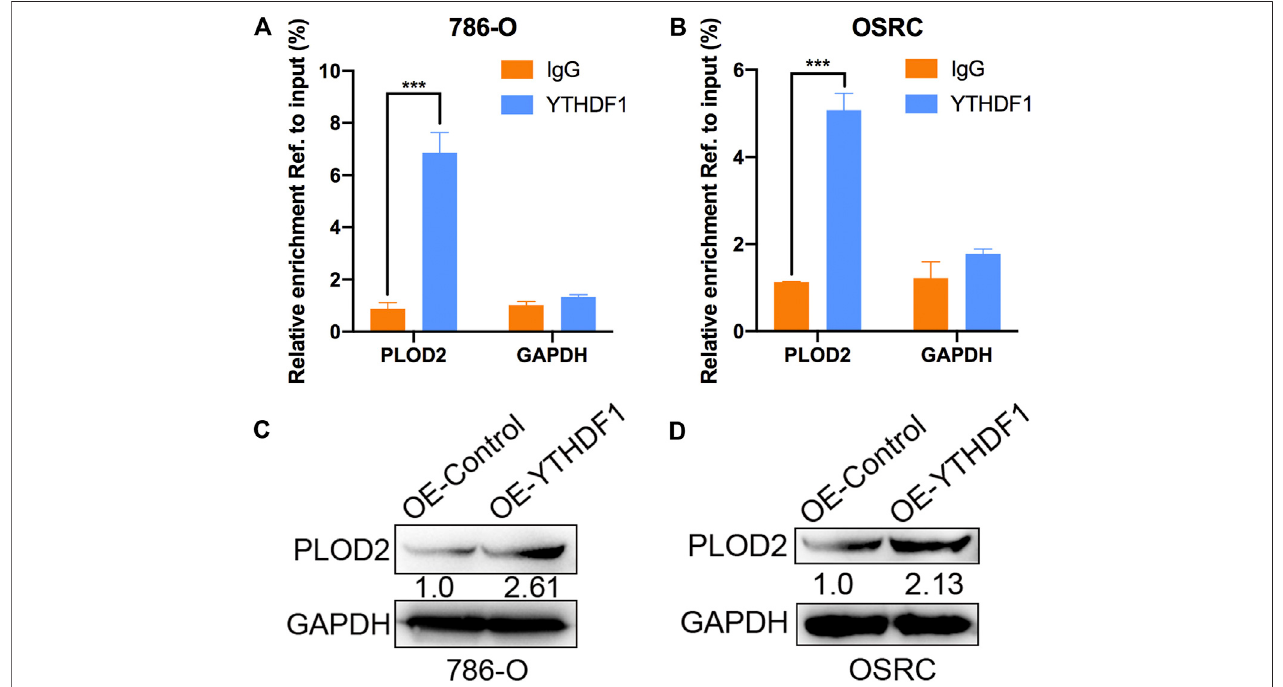
FIGURE6| YTHDF1involvedinm 6 AregulatedproteinlevelofPLOD2. (A,B) YTHDF1RIP-qPCRanalysisofPLOD2mRNAin786-OandOSRCcells.GAPDHasa negative control. (C,D) Western blot analysis of PLOD2 protein levels in 786-O and OSRC cells transfected with control or YTHDF1 construct for 24 h. *** p < 0.005.